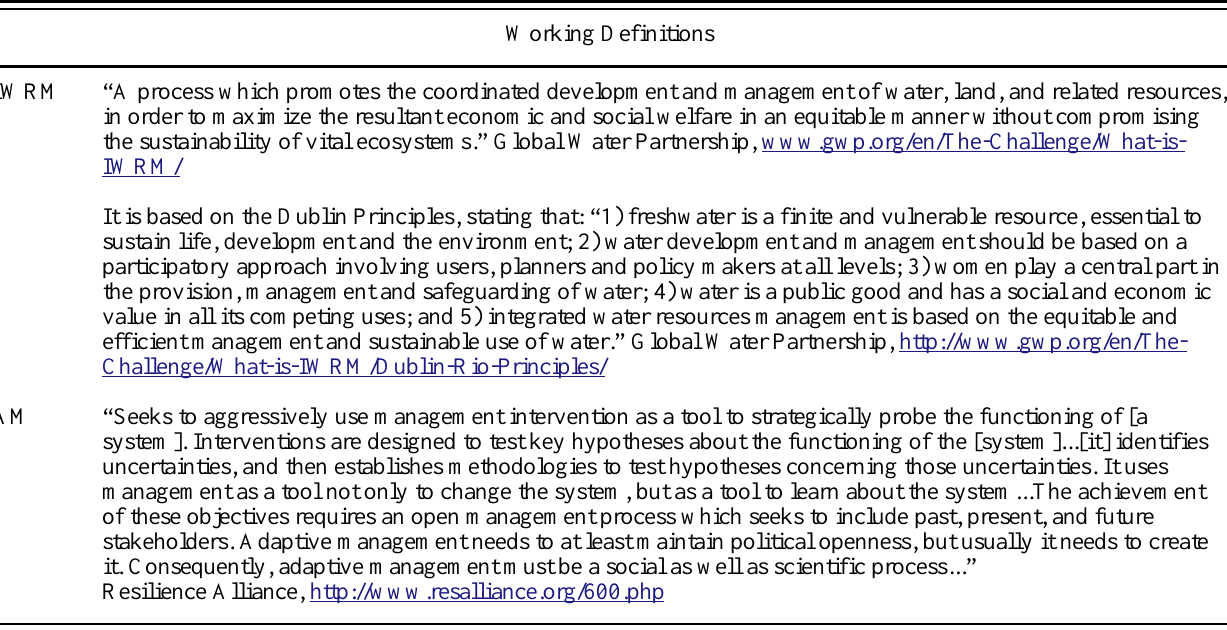
Table 1. Working definitions of integrated water resources management (IWRM) and adaptive management